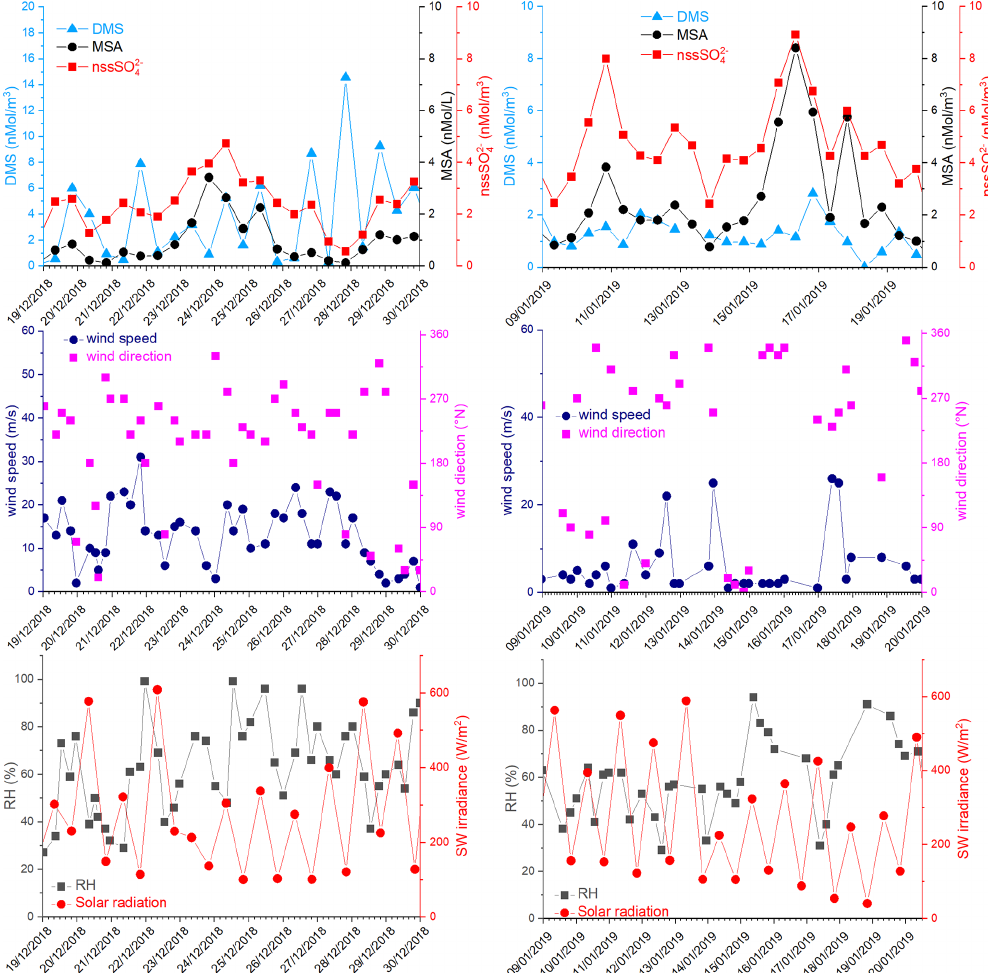
− , wind speed and direction, relative humidity (RH) and short-wave irradiance for the time 19–30 De- Figure 8. DMS, MSA and nssSO 2 4 cember 2018 and 9–20 January 2019. DMS and SW irradiance data are averaged over the same time interval of the aerosol sampling